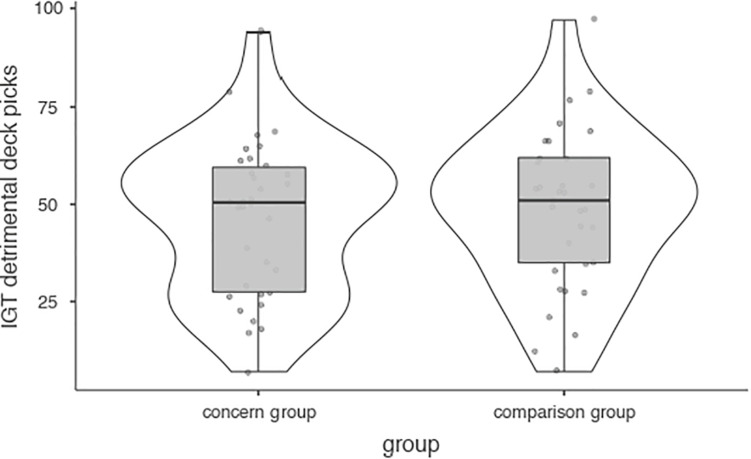
Iowa Gambling Task detrimental deck picks.